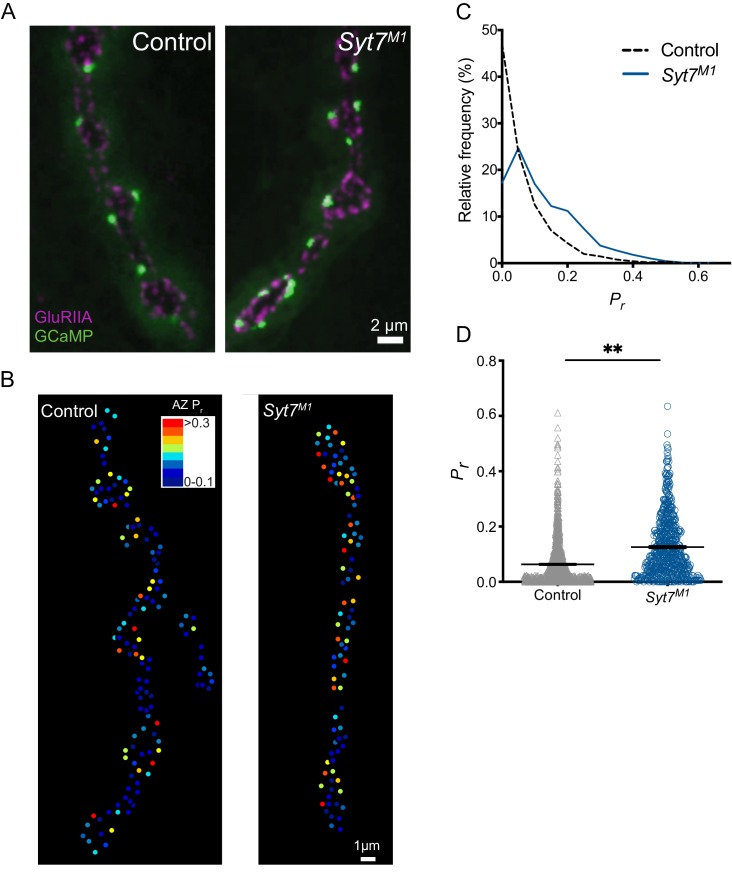
Quantal imaging reveals elevated release probability across the AZ population in Syt7 mutants.(A) Representative images of GluRIIA positive PSDs (red) and postsynaptic myr-GCaMP6 flashes (green) in response to evoked stimulation in control and Syt7M1 mutants. (B) Pr heatmaps for muscle 4 NMJs generated following 0.3 Hz stimulation for 5 min in control and Syt7M1 mutants. The Pr color map is displayed in the upper right. (C) Frequency distribution of AZ Pr after a 0.3 Hz 5 min stimulation for control (black dashed line) and Syt7M1 (blue line). (D) Quantification of mean AZ Pr for the two genotypes (p≤0.01, Student’s t-test; control: 0.063 ± 0.002, n = 1158; Syt7M2: 0.12 ± 0.004, n = 768).